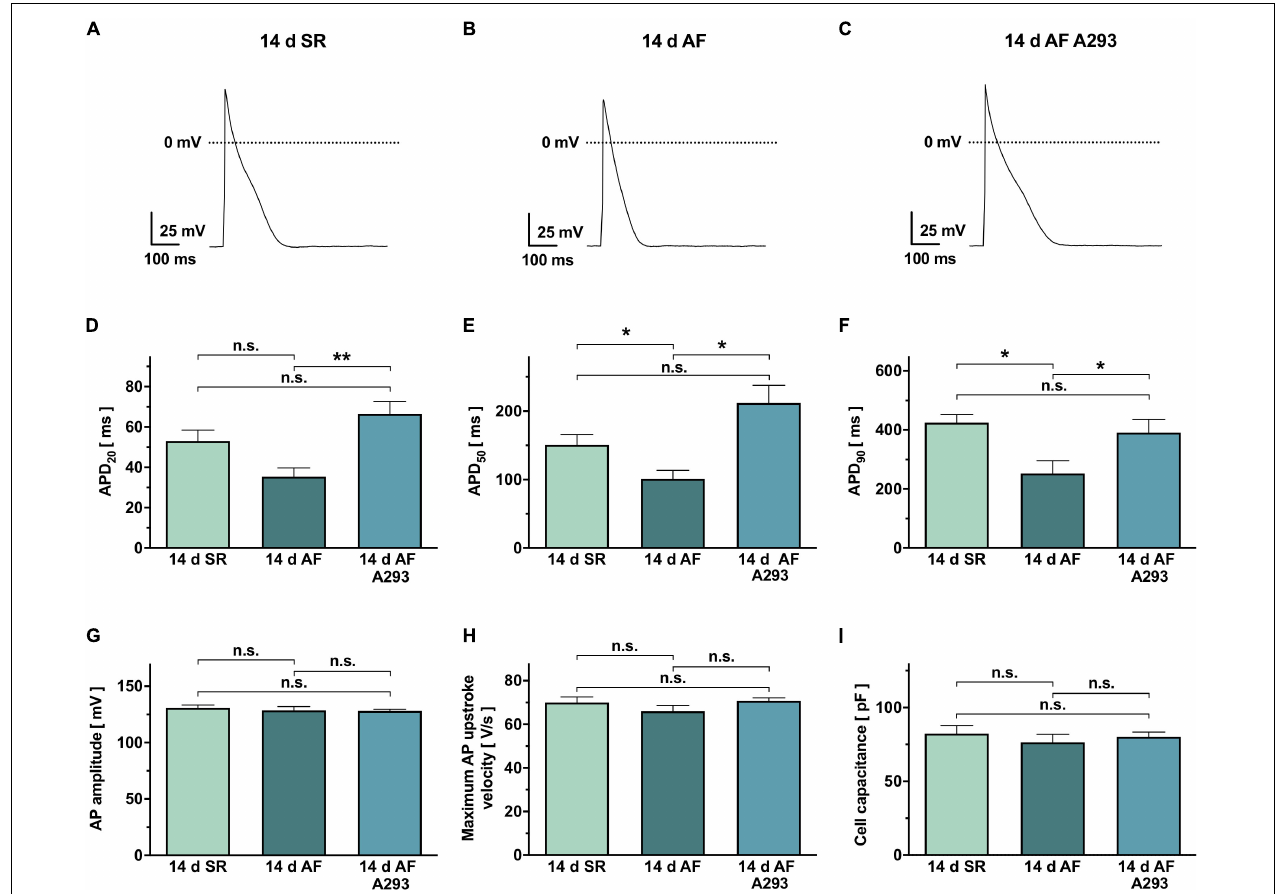
FIGURE 4 | Action potential recordings from isolated atrial cardiomyocytes. (A–C) Representative action potential (AP) recordings from atrial cardiomyocytes of the SR control group (A) , the atrial fibrillation (AF) group receiving sham treatment (B) , and the AF group receiving A293 (C) . (D–F) Comparison of the corresponding mean AP durations at 20% (APD 20 , D ), 50% (APD 50 , E ) or 90% repolarization (APD 90 , F ). (G,H) No statistically significant differences were observed among AP amplitude (G) or maximum AP upstroke velocity (H) . (I) Similar cell capacities were recorded in all 3 study groups. Means of n = 4–13 cells isolated from 4 animals per group; error bars, SEM; dashed lines, zero potential levels; * P < 0.05 and ** P < 0.01 from Student’s t